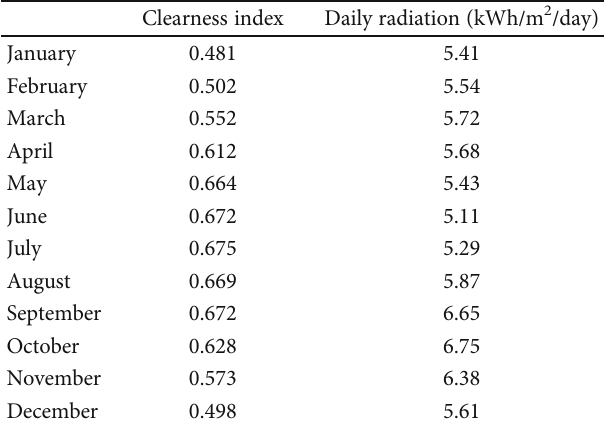
Table 1: Daily radiation and clearness index data for Mchinji. Clearness